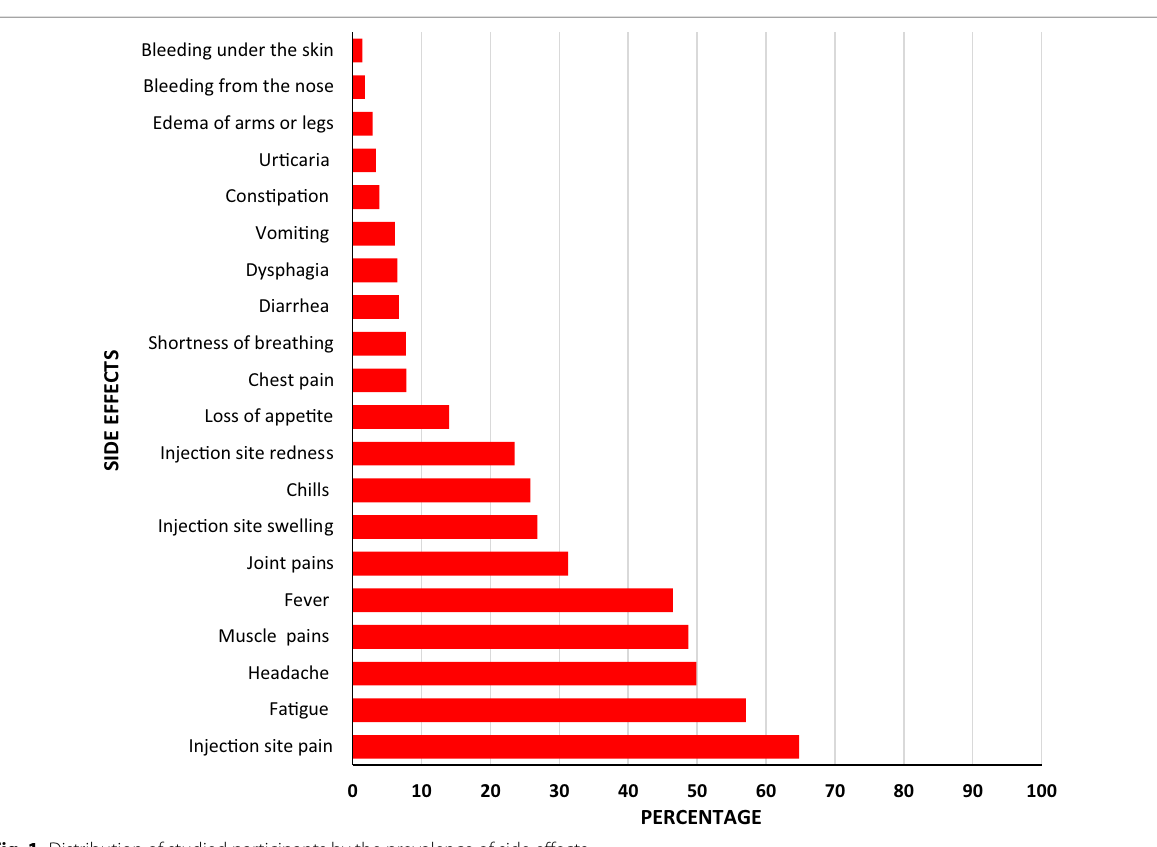
Fig. 1 Distribution of studied participants by the prevalence of side